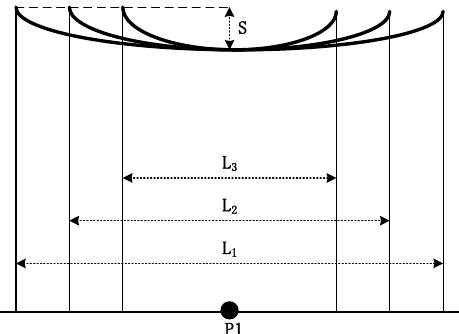
Figure 6. Span configurations of different lengths.